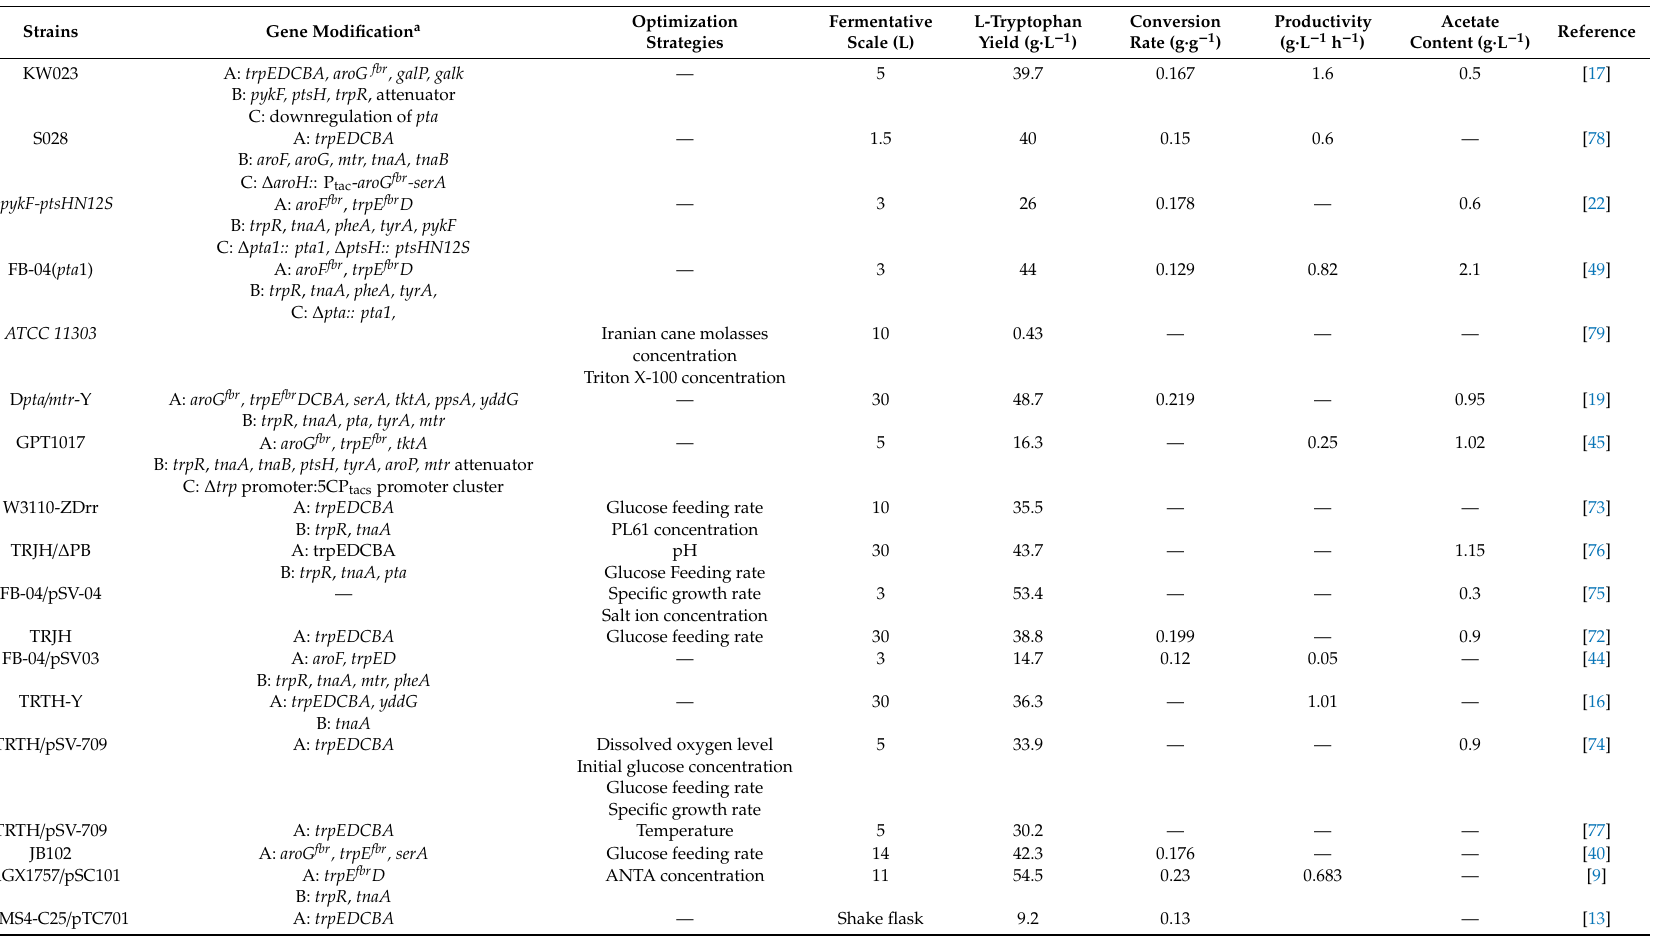
Table 1. Metabolic engineering and fermentation optimization strategies for L-tryptophan production by E. coli from